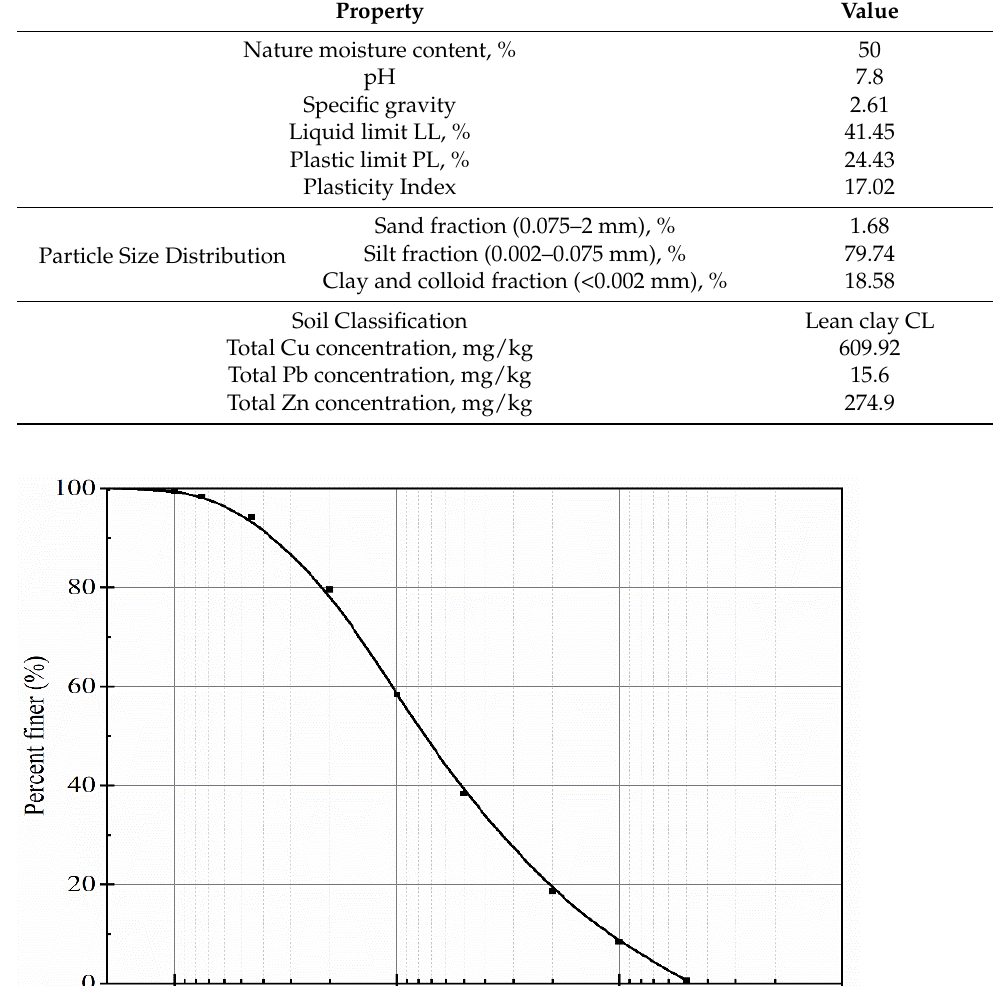
Table 1. Physical properties of the mining sludge collected from the actual copper mine site.